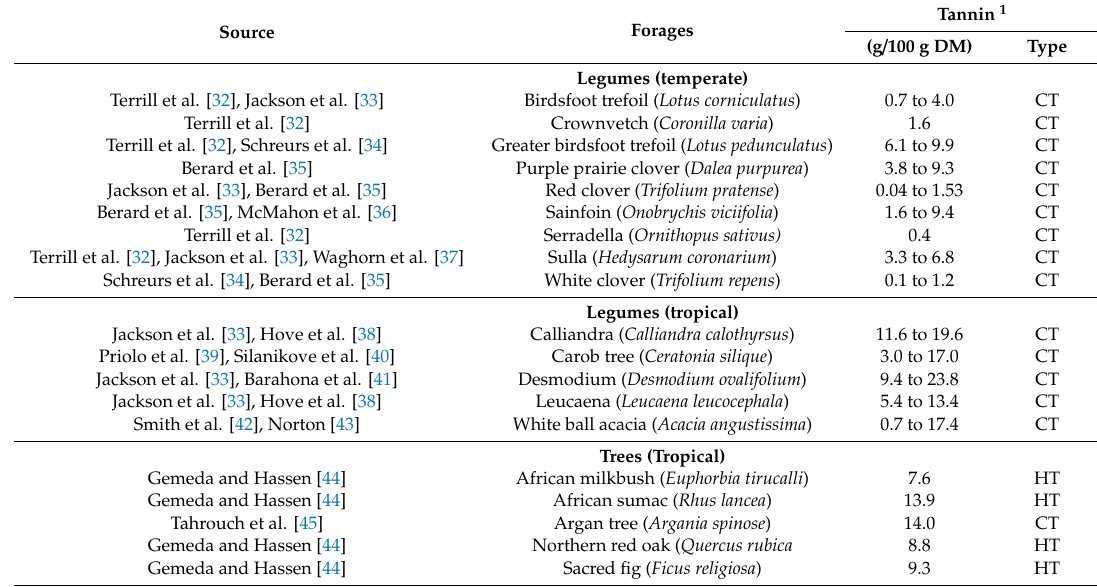
Table 1. Summary of the concentration and main type of tannins in some temperate and tropical